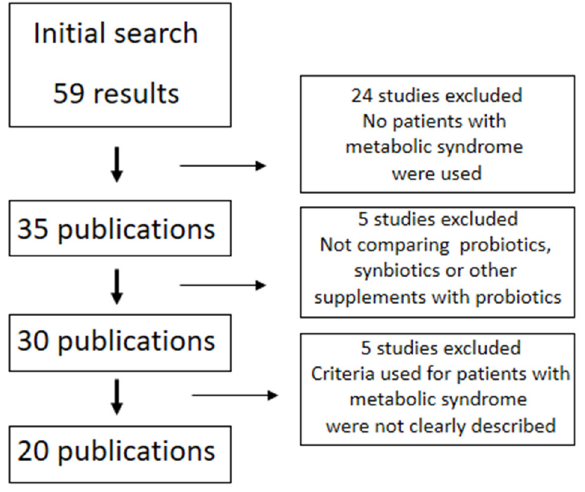
Figure 2. Diagram with the search results and criteria for selection of sources.